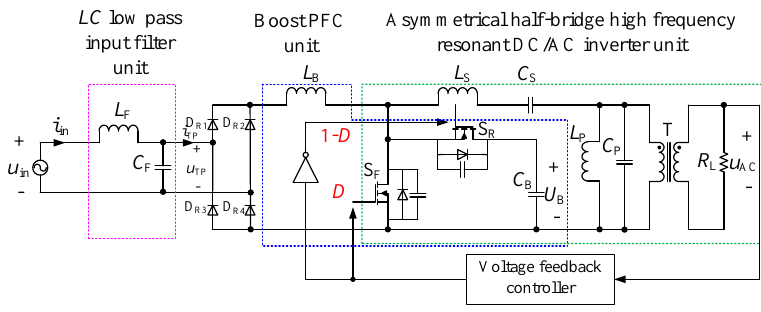
Figure 2. Single−stage high−frequency AC/AC converter with LC filter. Figure 2. Single − stage high − frequency AC/AC converter with LC